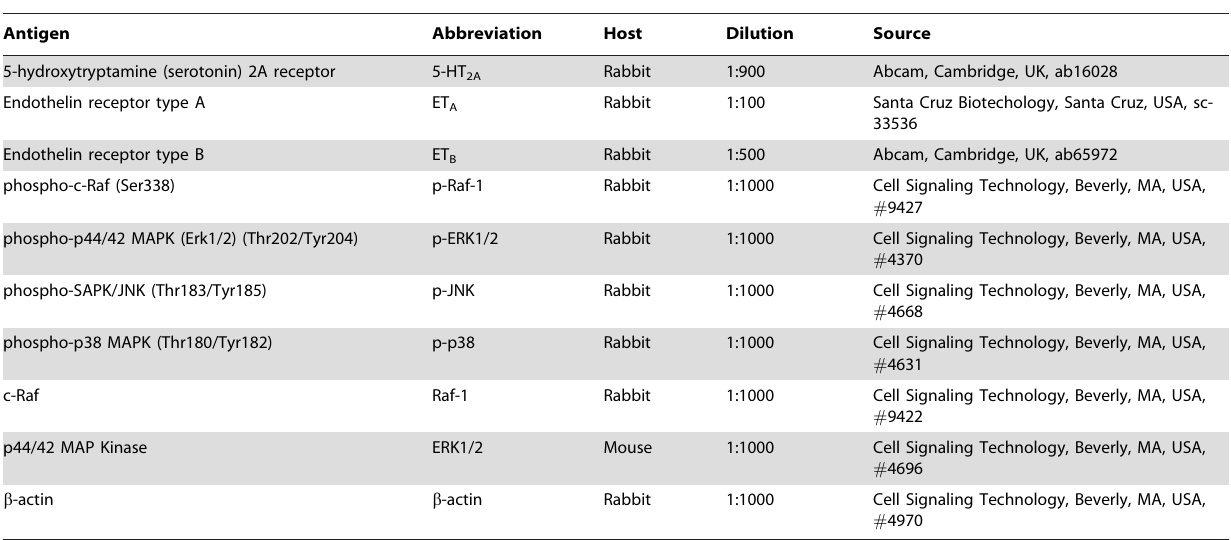
Table 3. List of primary antibodies used for Western